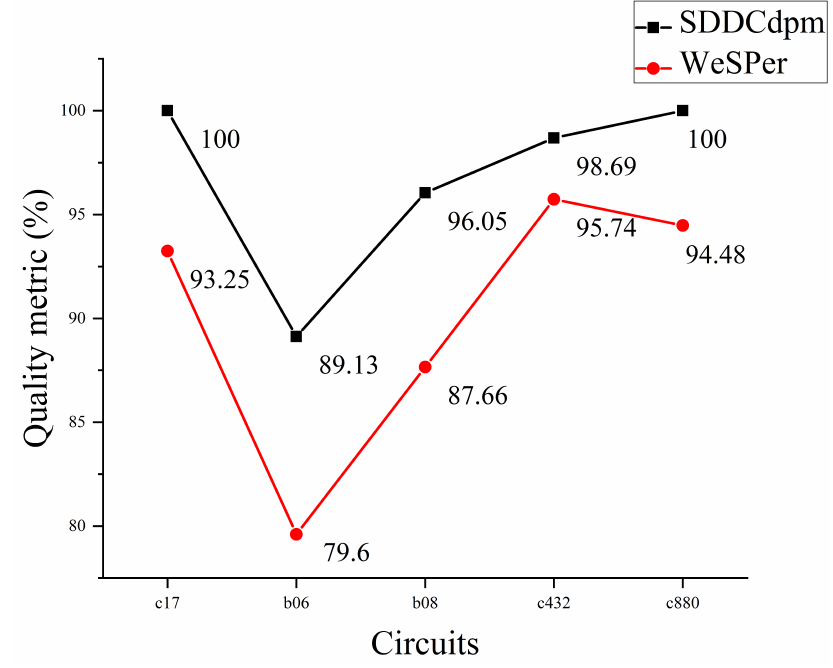
Figure 14. Comparison of SDDCdpm and WeSPer for FAST